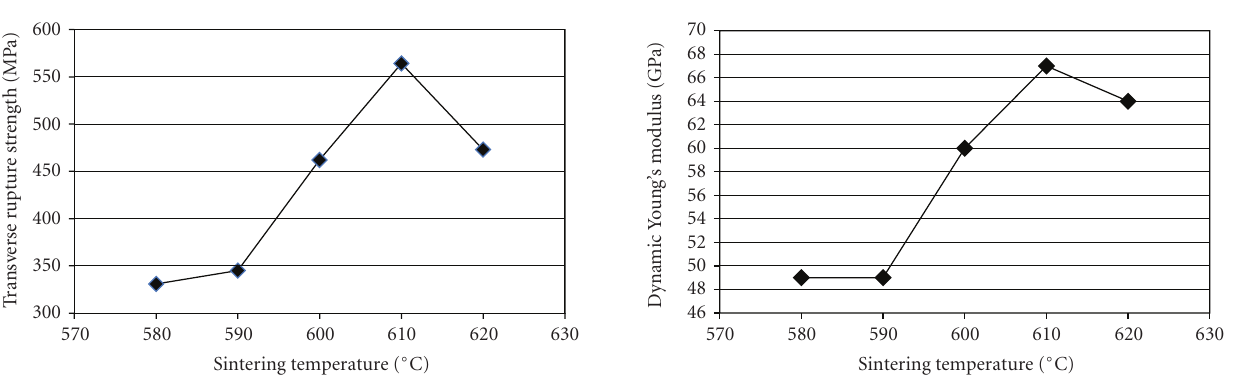
the fact that a high contiguity, as a consequence of optimum liquid phase sintering and greater rigidity from the solid- solid contacts, aids the hardness. On the other hand, too high sintering temperature ( > 610 ◦ C) should be avoided either, since grain growth as a consequence of increasing sintering temperature is detrimental, resulting in decreasing